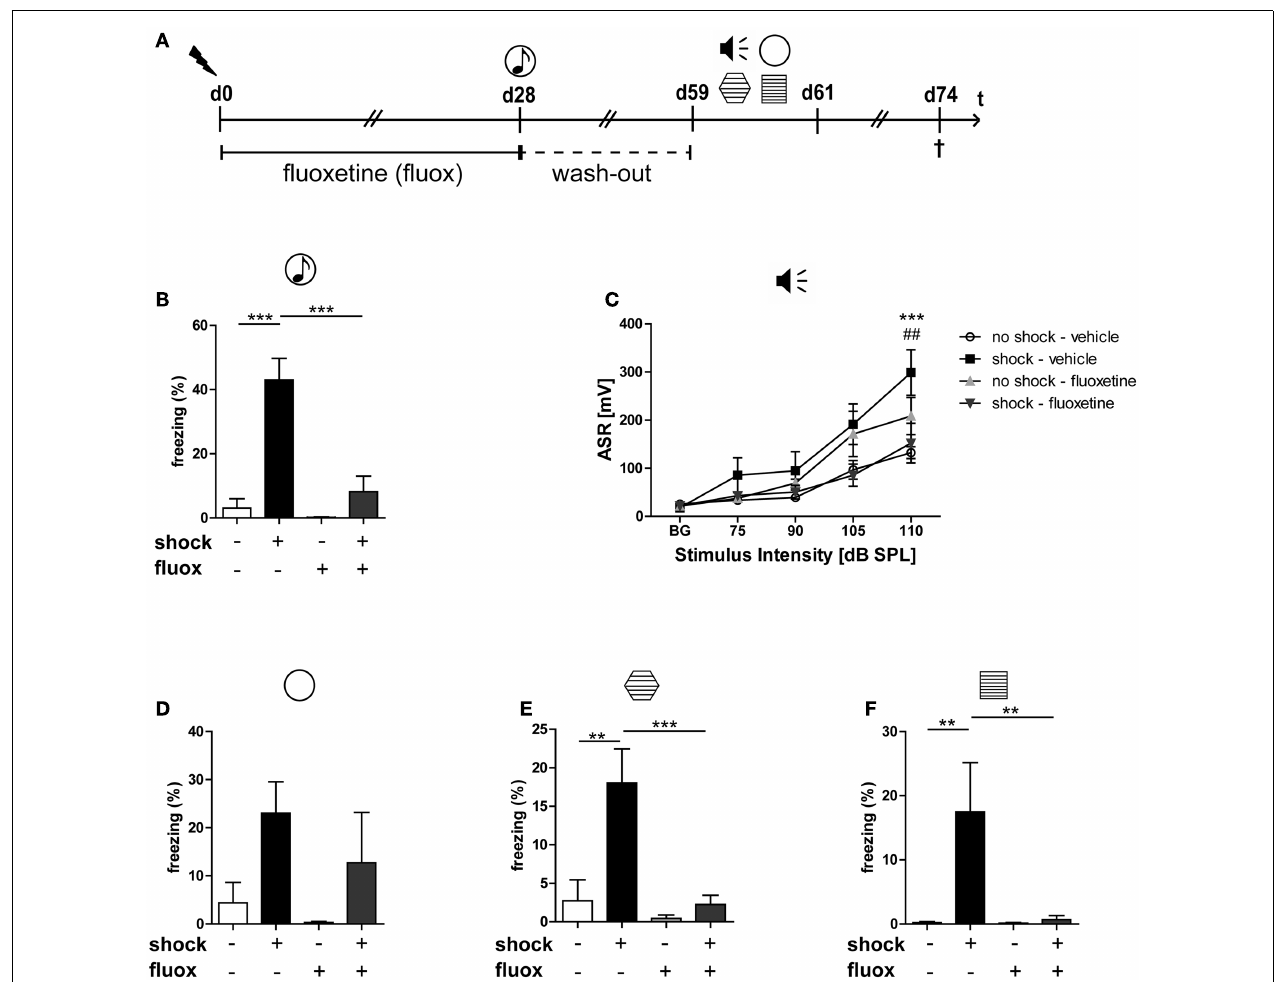
response by assessment of the freezing response both in a neutral experimental context (D) and in a grid context similar to the shock chamber